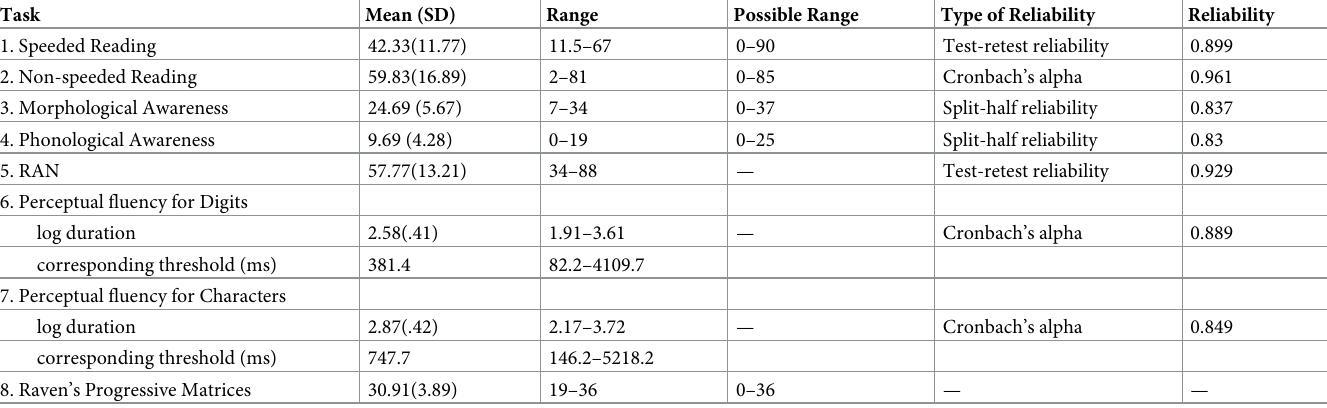
Table 1. Descriptive statistics and reliabilities of different reading and component skill measures. For perceptual fluency, the corresponding threshold values are directly transformed from log duration values in the table for easier interpretations of the findings.